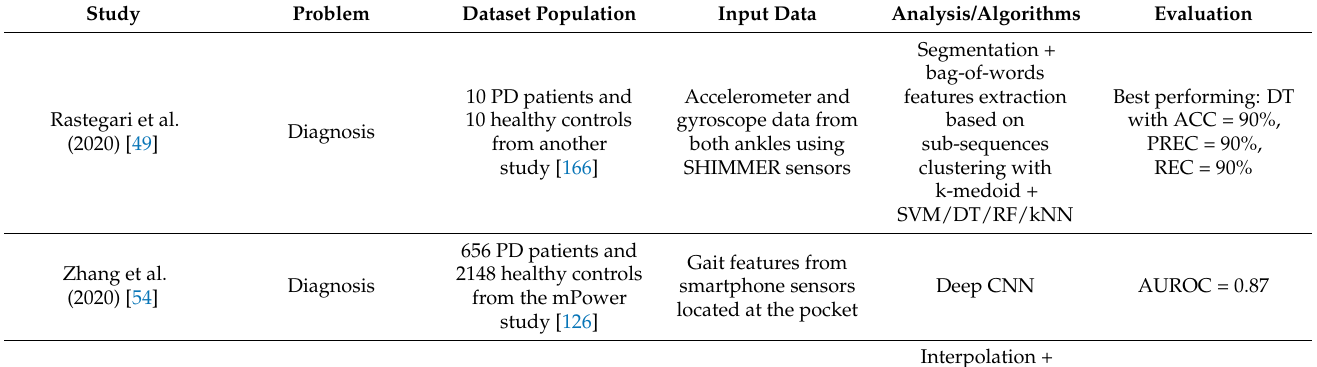
Table A1. Studies based on inertial